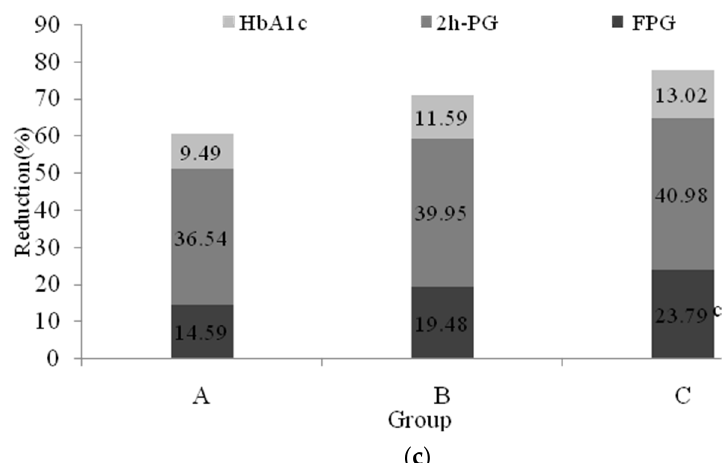
Figure 2. The 2h ‐ plasma glucose ( 2 h ‐ PG ） and fasting plasma glucose (FPG) of participants belonged to different groups. ( a ) the 2 h ‐ PG and FPG value; ( b ) hemoglobin A1c (HbA1c) value; ( c ) the reduction of FPG, 2 h ‐ PG and HbA1c. The results were expressed as mean (standard deviation). a compared with PG value at baseline ( p < 0.05); b compared with HbA1c value at the baseline ( p < 0.05); c compared with Group A at FPG reduction( p < 0.05).